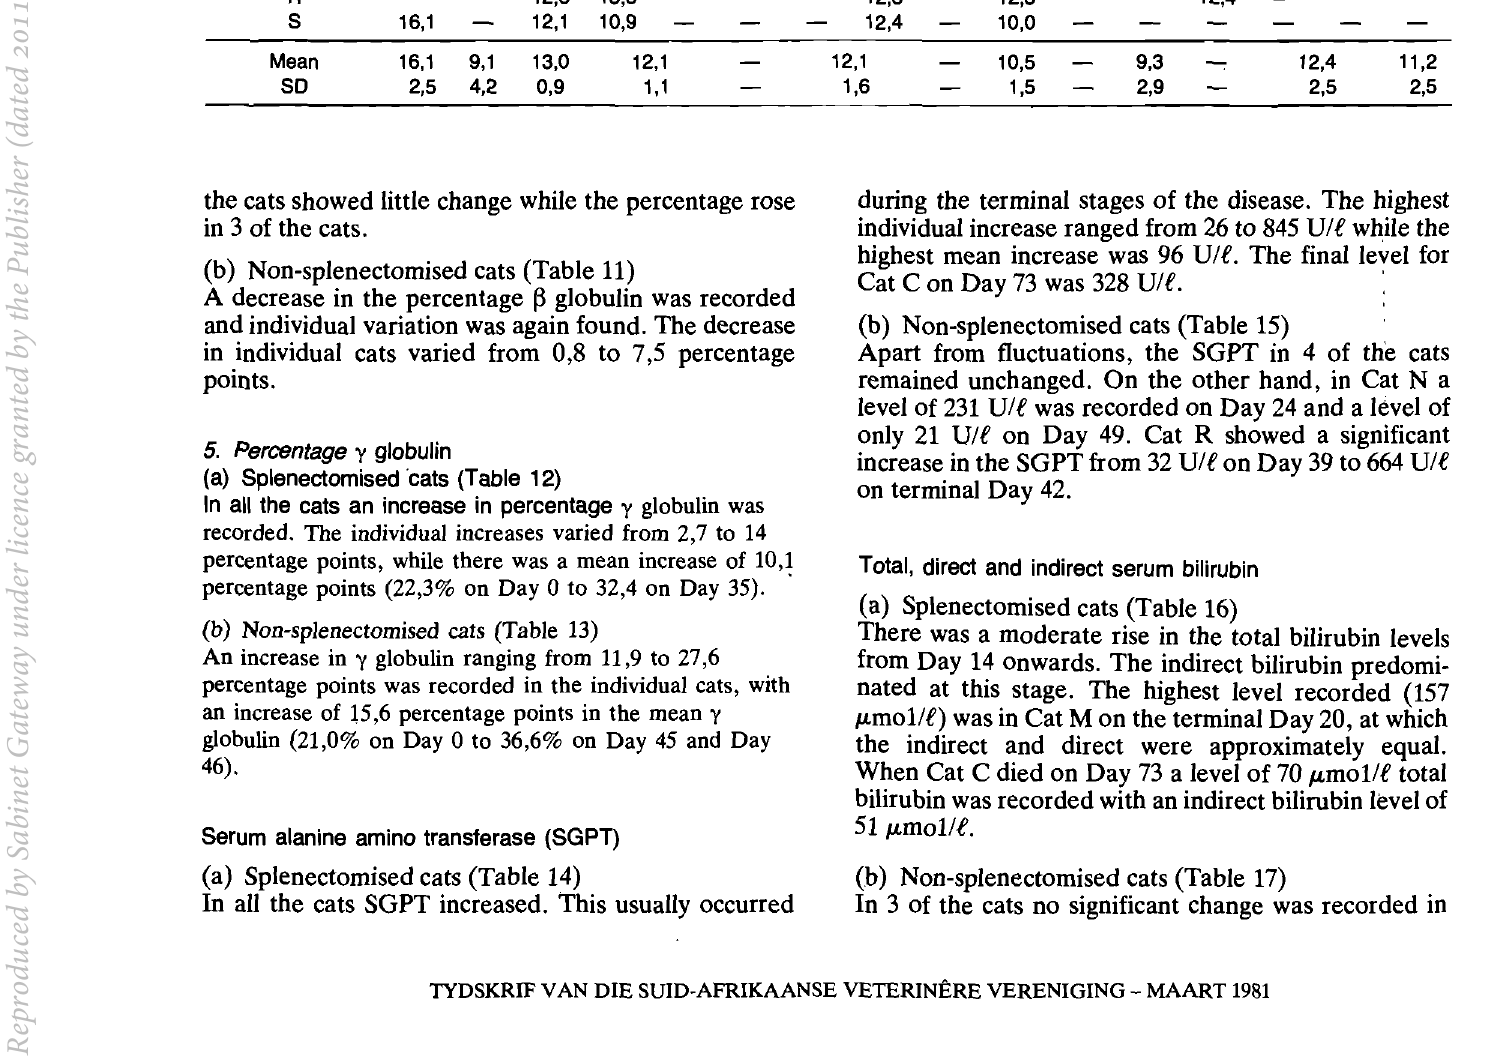
Table 9: CHANGES IN PERCENTAGE (X GLOBULIN IN NON-SPLENECTOMISED CATS FROM DAY OF INOCULATION (DAY 0) WITH B. FELIS INFECTED BLOOD